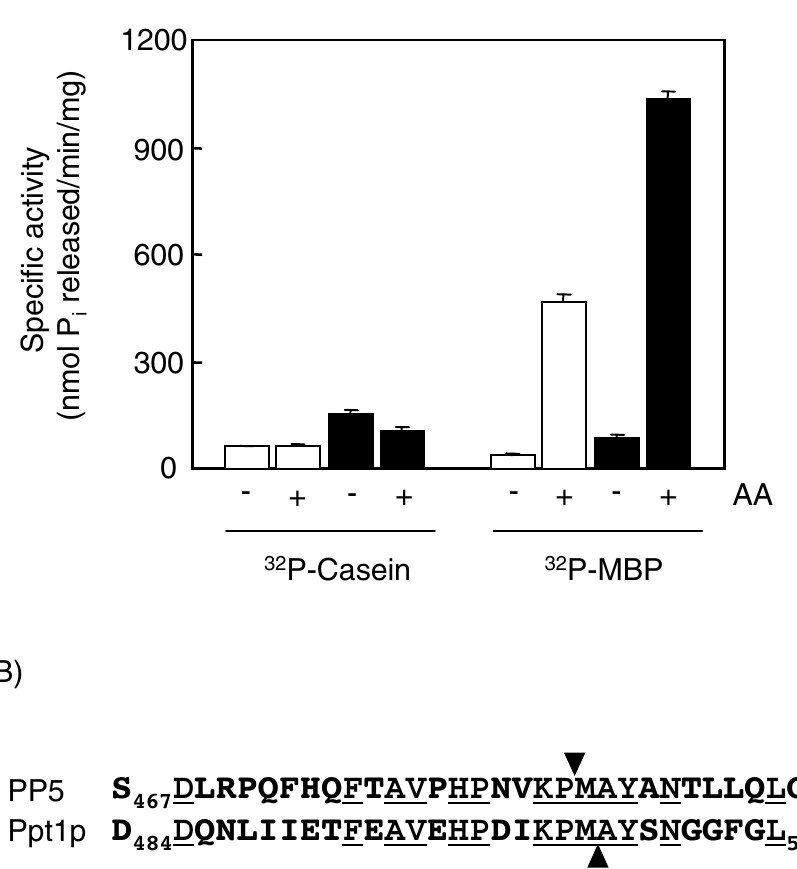
Figure 3 Effect of C-terminal truncation on Ppt1p activity . (A) Phosphatase activity of full-length Ppt1p ( (cid:1) ) or the C-terminal truncation mutant, Ppt1p (1–504) ( ■ ), was determined in the absence or presence of 250 µ M AA using 32 P-casein or 32 P-MBP as substrate. Data are the average ± S.D. of triplicate samples from a single experiment. Similar values were obtained in three independent experiments performed under the same conditions. (B) C-terminal sequences of Ppt1p and PP5 are aligned to dis- play the truncation sites for Ppt1p (1–504) and PP5 (1–486) [19]. The truncation sites are indicated with the filled triangles. Bold underlined residues are conserved in both Ppt1p and